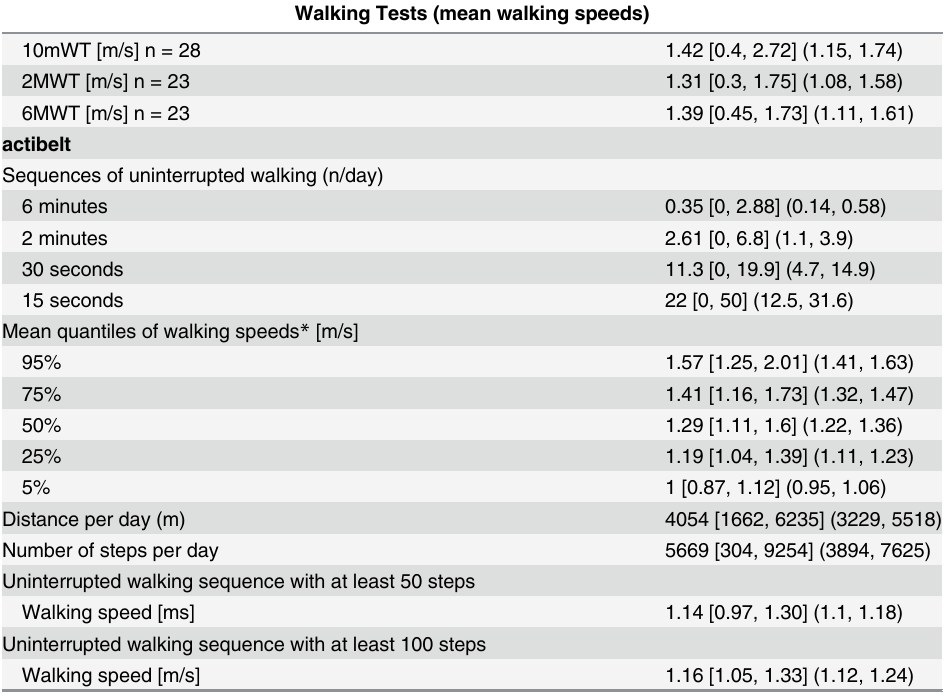
Table 2. Descriptive Statistics